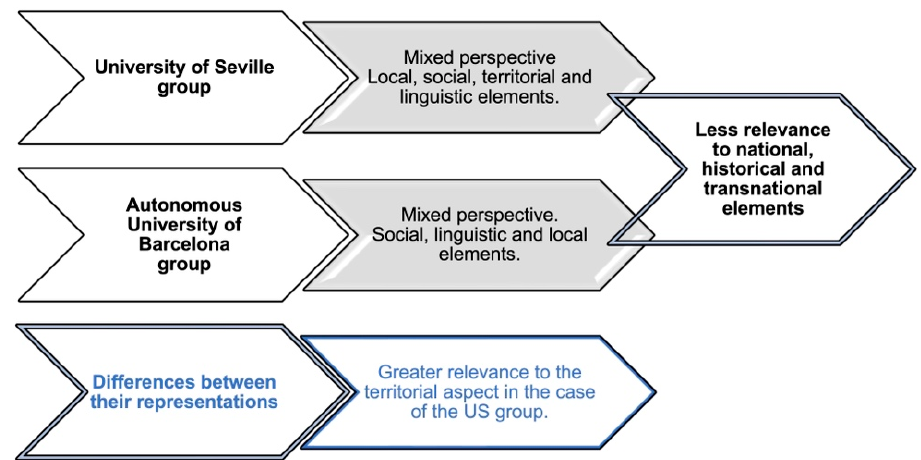
Figure 5. Representations on the construction of their identities and their differences.